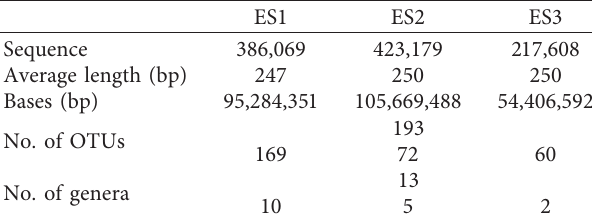
Figure 2: Genus-level percentage of fungal composition based on HTS of the ITS1 amplicon for all three E. sinensis samples. Table 2: Summary of the HTS of CaM amplicon for E. sinensis